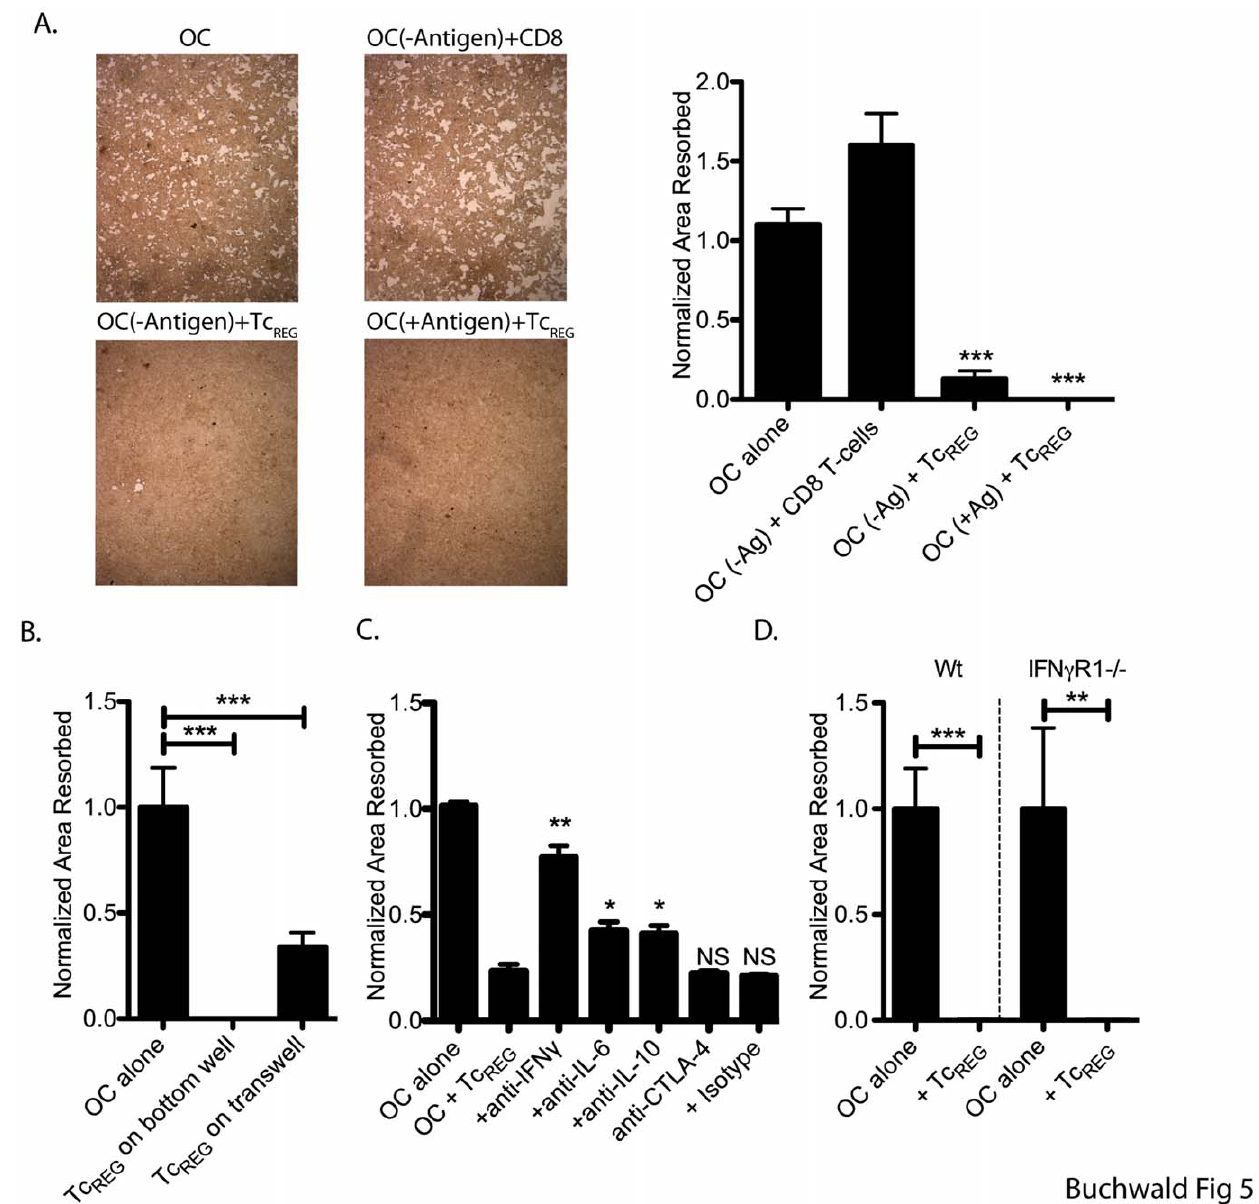
Figure 5. Tc REG inhibit osteoclast activity in an antigen- and contact-independent manner by secreted cytokines. A . Osteoclasts were seeded on hydroxyapatite-coated plates and allowed to adhere overnight. The osteoclasts were pulsed with SIINFEKL peptide ( + Antigen) or a control FLAG peptide (-Antigen). OT-I Tc REG or naı¨ve CD8 T-cells were added and co-cultured for 7 days. Cells were re-fed with medium containing M-CSF and RANKL every 2 to 3 days. The plates were then treated with bleach solution, washed, dried and photographed. Representative photomicrographs are shown on the left. Quantitation from four experiments of three wells each is shown on the left. B . Tc REG were added to top-insert of transwell (0.45- m membrane) separated from the osteoclast plated on 24-well Corning Osteo-Assay plate. Osteoclast activity was determined by quantifying total pit area resorbed following 10 days of co-incubation. C . In a culture of both osteoclast and Tc REG on Corning Osteo-Assay plates, neutralizing antibodies against IL-10 (25 m g/ml), IFN- c (50 m g/ml), IL-6 (20 m g/ml) or CTLA-4 (10 m g/ml) were added to determine their impact on osteoclast activity. The cells were co-cultured for 10 additional days, and re-fed with media containing M-CSF, RANKL every three days. Re-feed media with antibodies were added on days 3 and 6. D . Pitting assay as described in Panel C were conducted in parallel using osteoclasts from either wild type (WT) or IFN c R1 2 / 2 mice. Statistical significance of area resorbed was assessed by non-parametric paired T test: *: P , 0.05, **: P , 0.01 and ***: P , 0.001 in comparison to osteoclast alone wells.